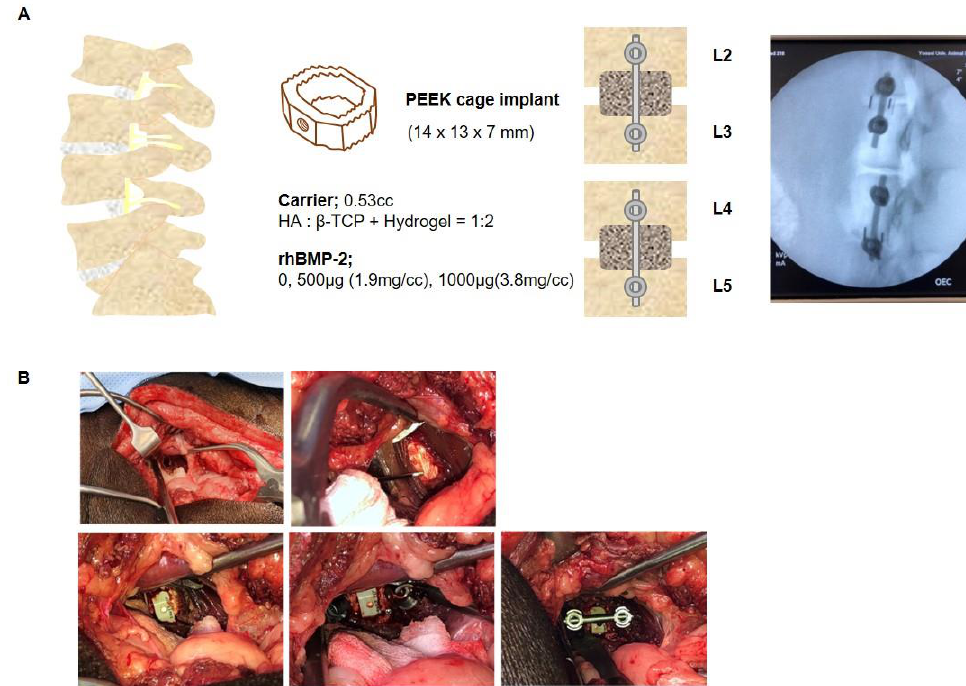
Figure 7. Establishment of the swine OLIF model. ( A ) Schematic and X-ray images of the swine oblique lateral interbody fusion (OLIF) in the lumbar spine. rhBMP-2 (0, 500 µ g [1.9 mg/cc]), 1000 µ g [3.8 mg/cc]) was mixed with 0.53 mL of the bone graft material (BGM). The BGM was used to fill the PEEK cage (14 × 13 × 7 mm) and implanted at the lumbar 2–3 and 4–5 levels. ( B ) Steps of OLIF surgery in the swine lumbar spine.